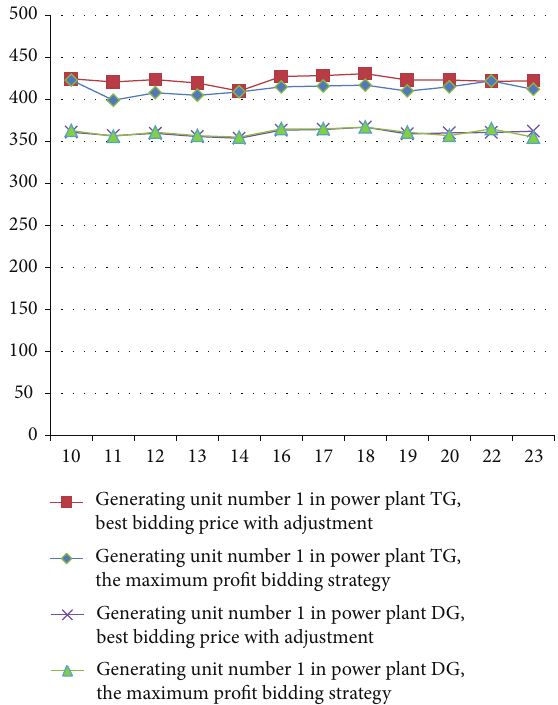
Figure 7: The relationship between ESS and bidding